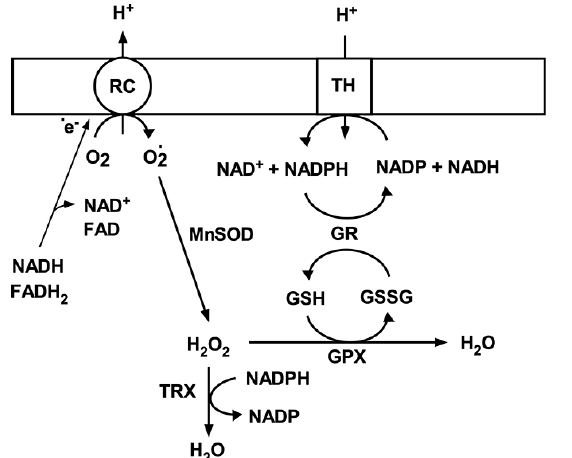
Figure 2. Mitochondrial antioxidant system. Superoxide ( O 2 • - ) generated by respiratory chain complexes (RC) is dismutated to hydrogen peroxide (H 2 O 2 ) by MnSOD. H 2 O 2 is then converted to water either by glutathione peroxidase using reduced glutathione (GSH) or thioredoxin peroxidase (TRX). Oxidized glutathione (GSSG) is then reduced back to GSH by glutathione peroxidase (GPX) using NADPH as an electron donor. NADP is then reduced by transhydrogenase; that is driven by mitochondrial membrane potential and transferring electrons from NADH.